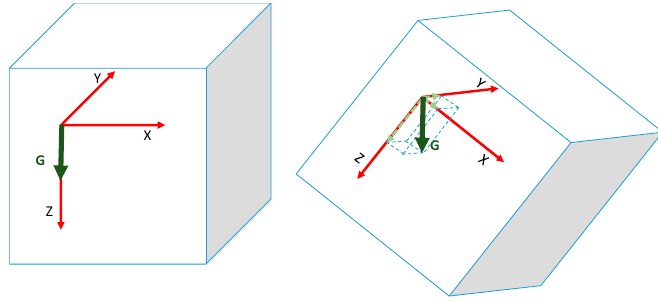
Figure 14. G vector in a stopped and in a spun cube.